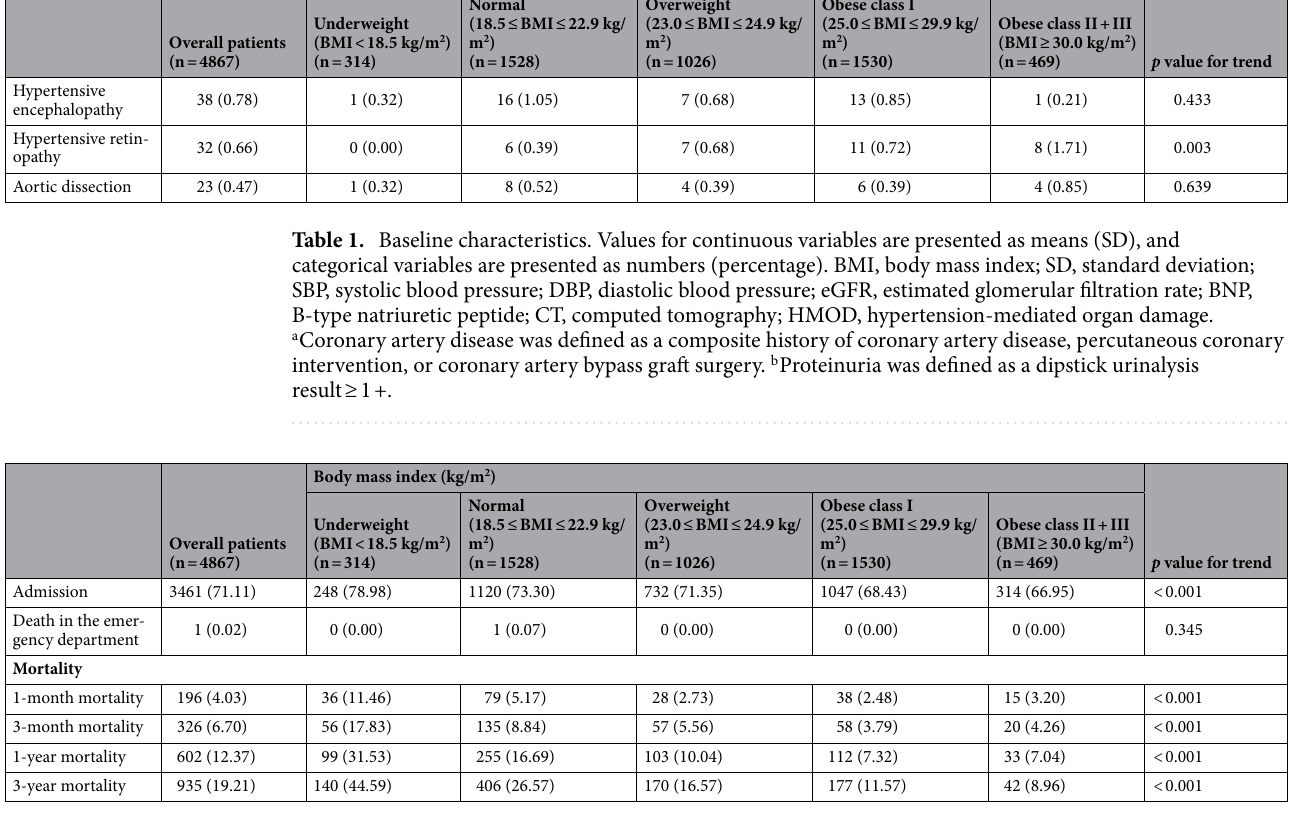
Table 2. Clinical outcome. Values are given as numbers